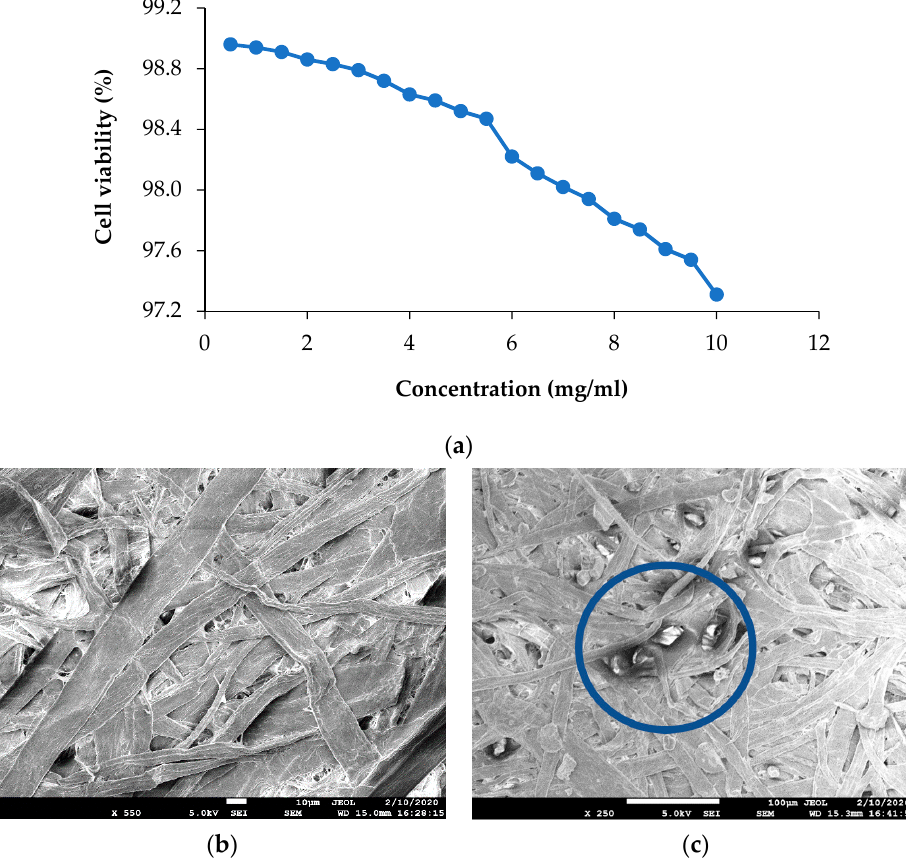
Figure 5. ( a ): Viability of Caco-2 cells exposed to increasing concentration of 1% gum arabic capped; IHNP’s; ( b ): Scanning electron microscopy image of control cellulose paper; ( c ): Scanning electron microscopy image of IHNPs, embedded cel- lulose paper.